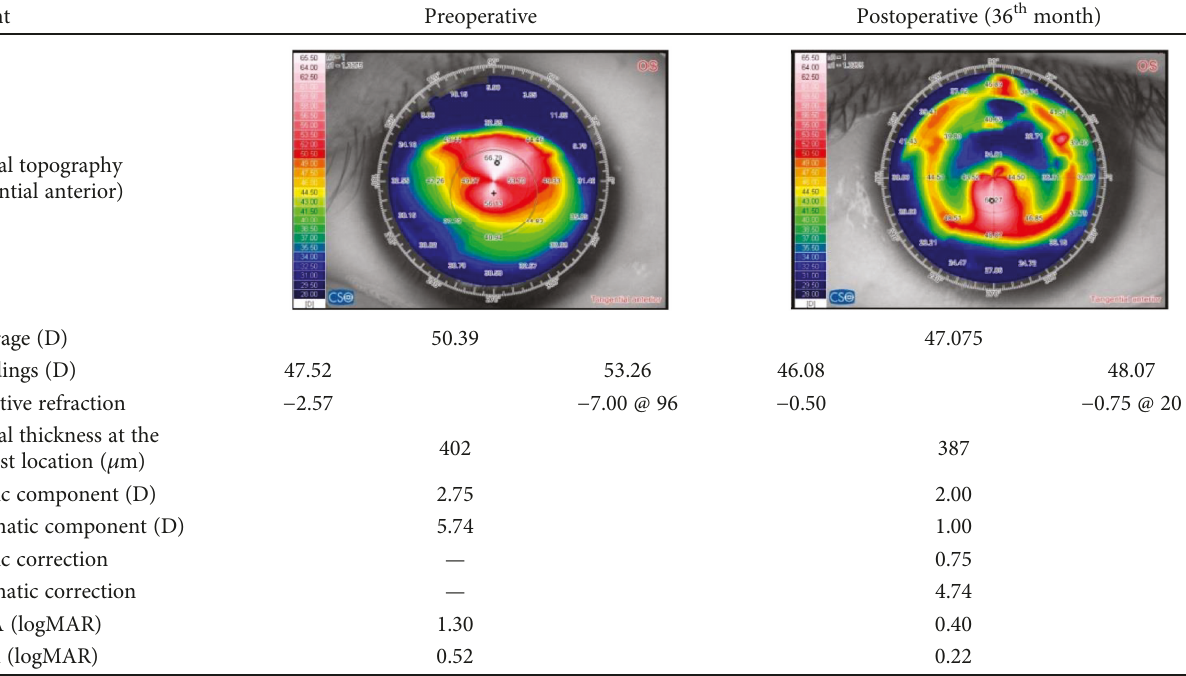
Table 3: A comparison between the preoperative and postoperative data of one female patient after 3 years of CXL PLUS.